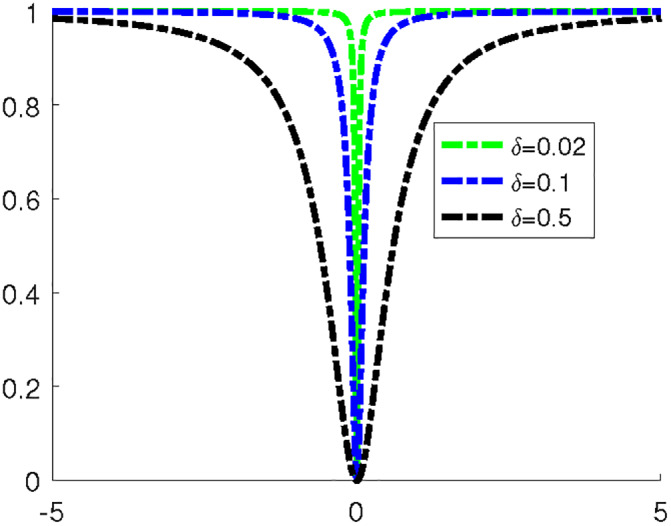
Diagram of sparse function designed in our work.